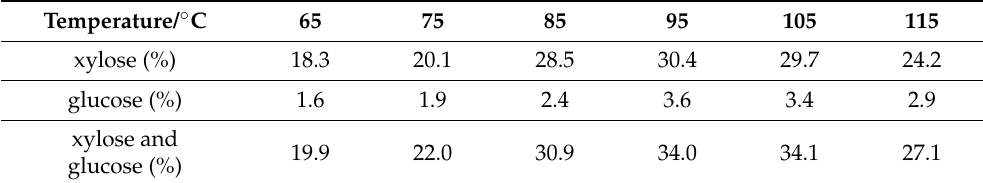
Table 2. Effect of temperature on xylose and glucose yield in the first step.